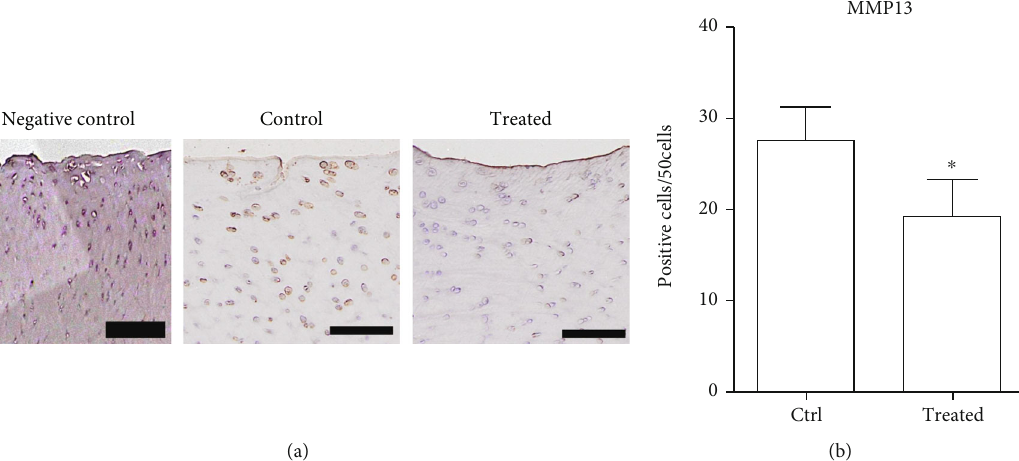
Figure 8: Immunohistochemistry of catabolic marker MMP13. (a) Representative image of MMP13 in the cartilage of normal cartilage (negative control), normal saline control, and HUCMSC+HA-treated knee. Scale bar = 100 μ m . (b) The 1 × 10 7 HUCMSC+HA-treated joints show signi fi cantly lower expression of MMP13 than the normal saline control joints ( n = 4 ). ∗ p = 0 : 03 by the Student t -test. Ctrl: control.